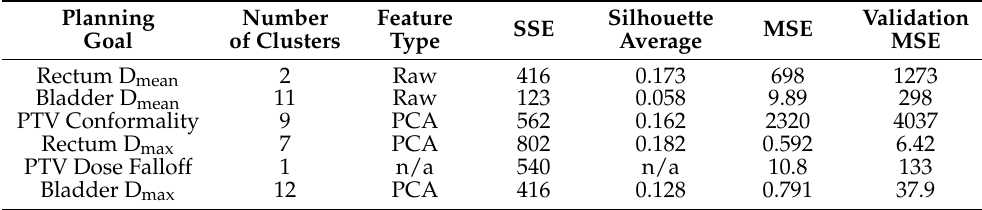
Table 7. A summary of final PGAP-ML clus models defined using the training